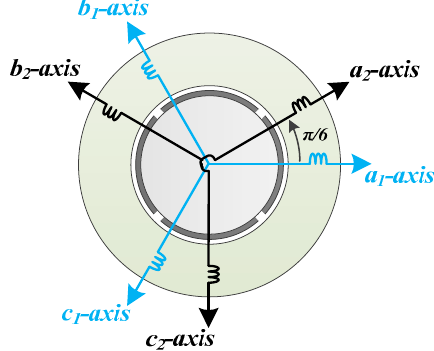
Figure 1. Six-phase surface-mounted permanent magnet synchronous motor with two sets of three phase windings and separated neutral points.